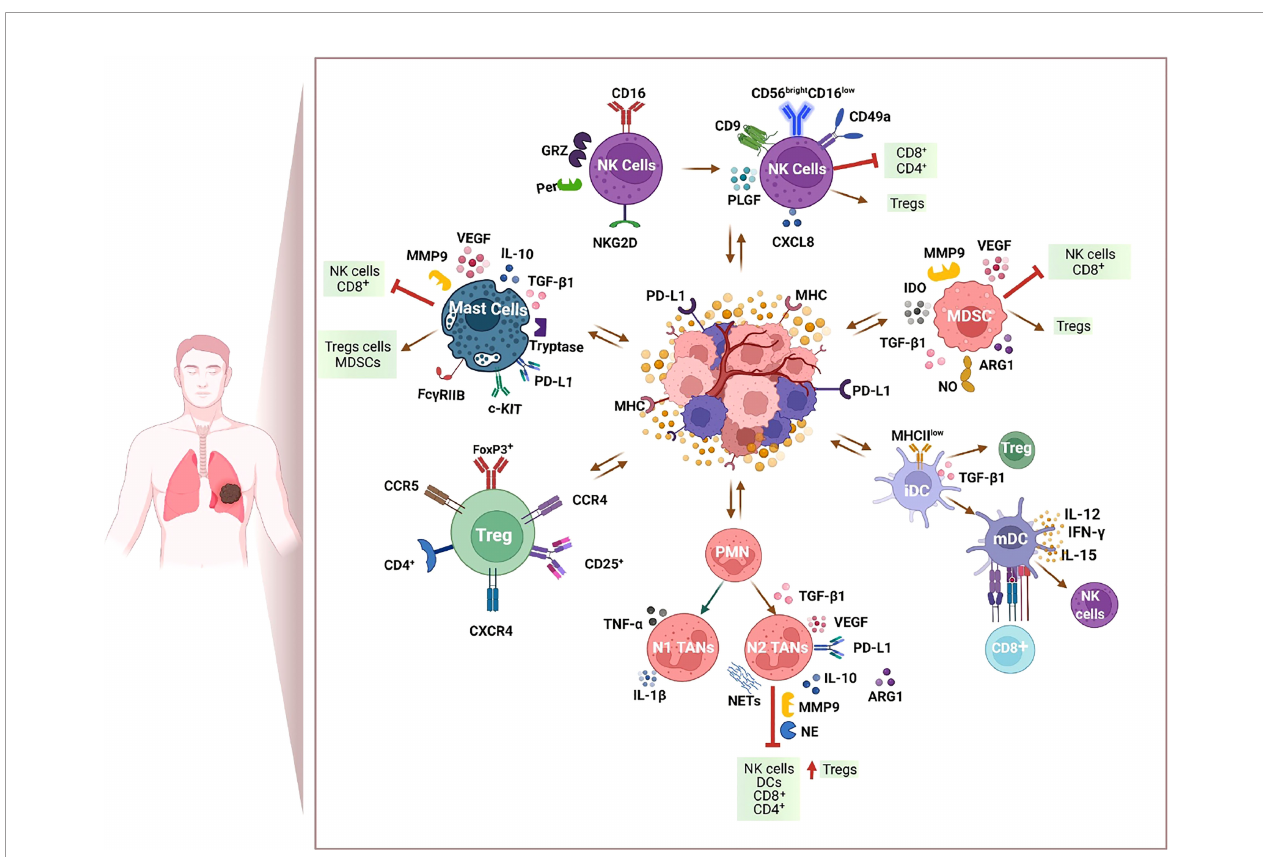
FIGURE 1 | Immunosuppressive milieu within the tumor immune microenvironment (TIME) of NSCLC. Immunotherapy resistance is marked by an immunosuppressive TIME and includes tumor-derived factors, in fi ltration of T regulatory cells (Tregs), myeloid-derived suppressor cells (MDSCs), and mast cells that, in turn, favor the polarization toward a protumor phenotype of other immune cells such as neutrophils, dendritic cells (DCs), and natural killer (NK) cells. Figure created with